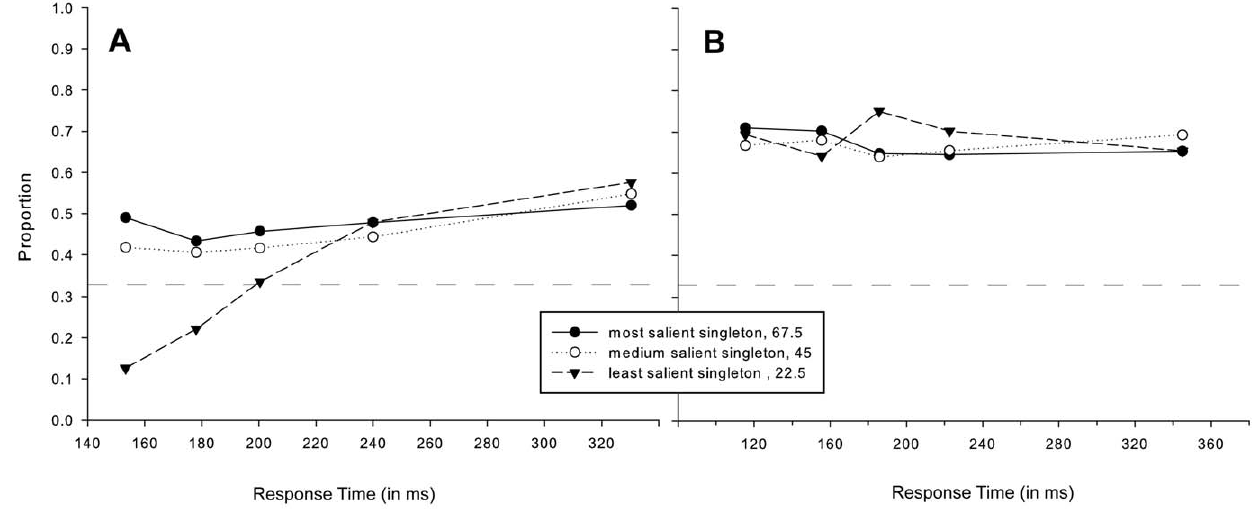
Figure 6. Goal-driven selection in Experiment 2. Proportions of eye movements correctly directed toward the right-tilted target singleton, averaged over all salience conditions, separately for each bin of the response time distribution for A) initial and B) second saccades.